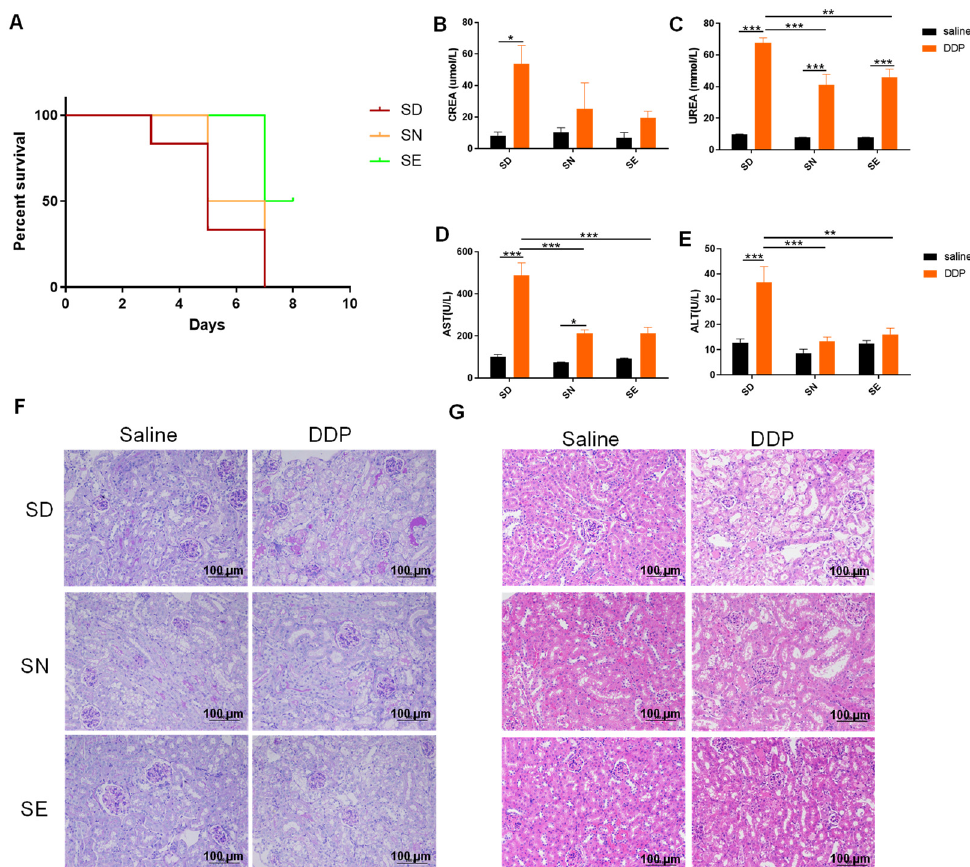
Figure 2. Selenium status in diet affects mice nephrotoxicity caused by DDP. ( A ) Survival curve of mice treated with 9 mg/kg DDP ( n = 6); ( B , C ) serum CREA, UREA levels 72 h after DDP administra- tion ( n = 4–6); ( D , E ) serum AST, ALT levels 72 h after DDP administration ( n = 5–6); ( F , G ) kidney tissues were stained and observed via periodic acid–Schiff staining and hematoxylin-eosin staining 72 h after DDP administration, magnification 200×, scale bar 100 µm, n = 3. A representative example was shown. Data were presented as mean ± SEM; * p < 0.05; ** p < 0.01; *** p < 0.001; two-way ANOVA. SD, selenium-deficient; SN, selenium-normal; SE, selenium-enriched; DDP, cisplatin.